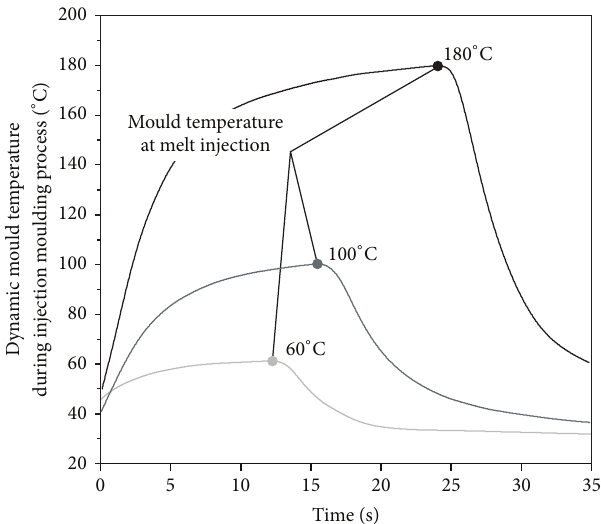
Figure 2: Mould temperatures during the injection moulding process to achieve varied morphology in the specimens (close-to- cavity